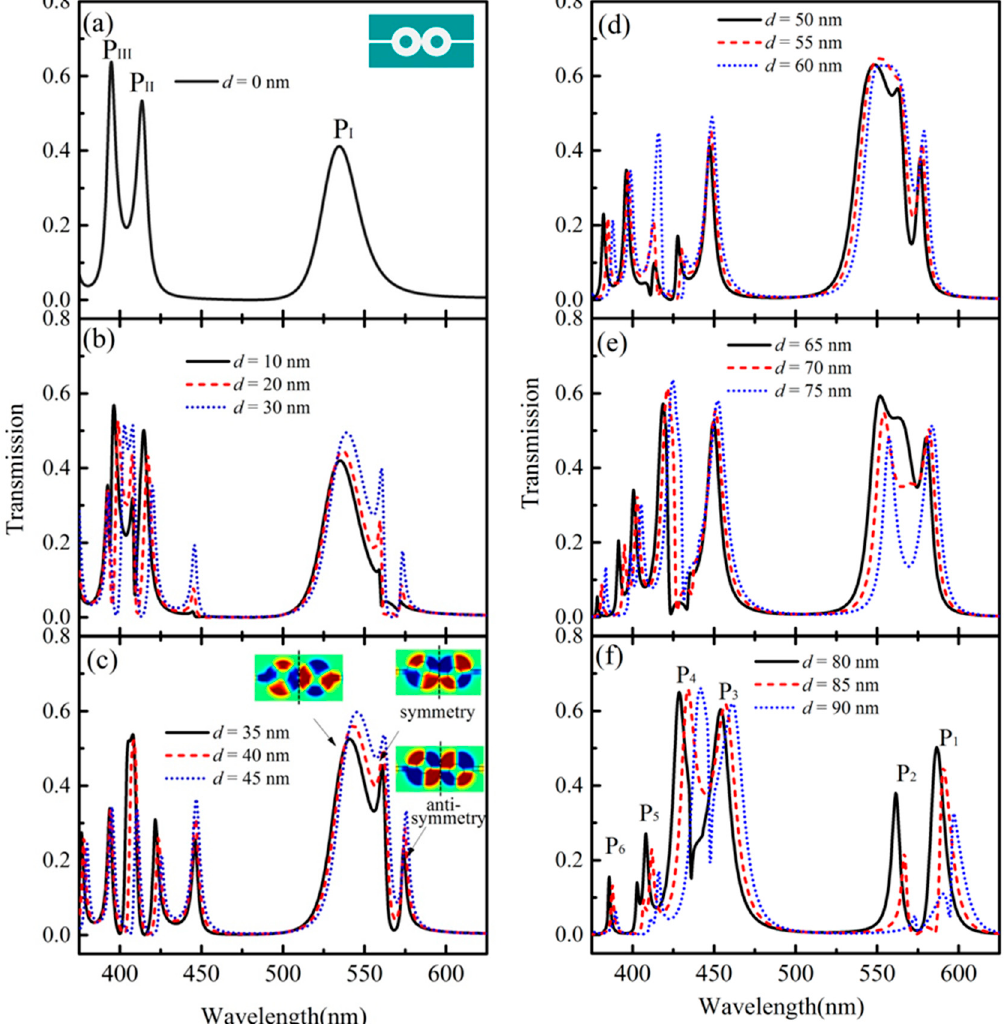
Figure 3. Transmissions for the cases of ( a ) the symmetric structure with the left and right metal cores located at the center of the corresponding cavity, i.e., d = 0; and the asymmetric structure with the left and the right metal cores respectively deviating along + y and − y -axis direction, but with the same deviation distance of d ; ( b ) d = 10, 20, and 30 nm; ( c ) d = 35, 40, and 45 nm; ( d ) d = 50, 55, and 60 nm; ( e ) d = 65, 70, and 75 nm; and ( f ) d = 80, 85, and 90 nm.